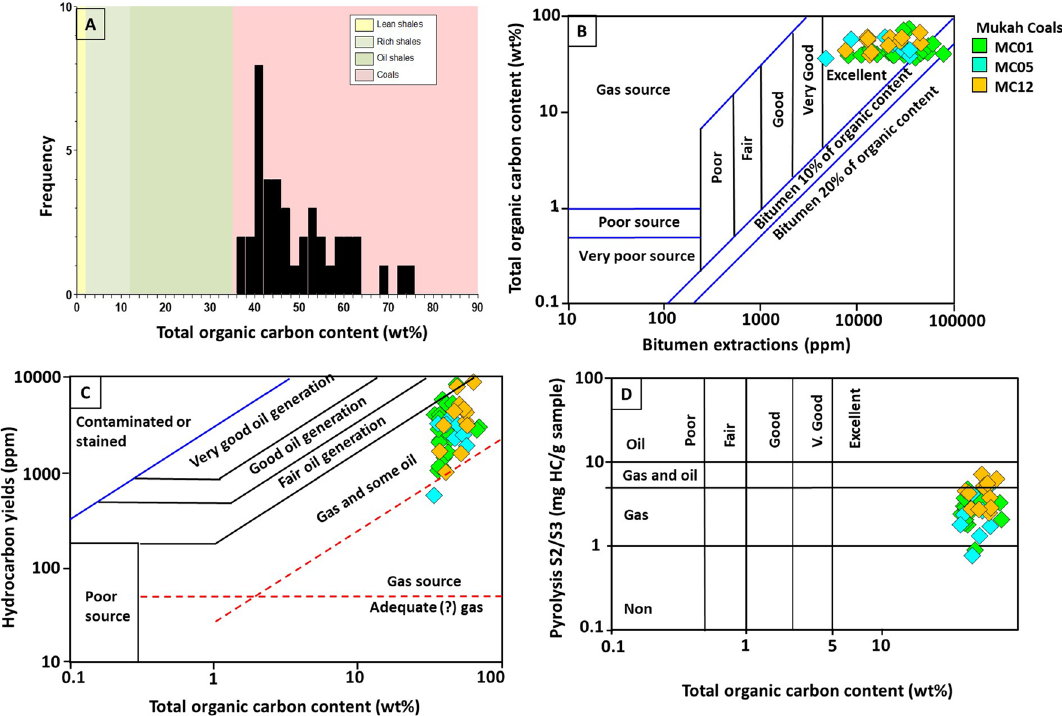
Figure 6. ( A ) Histogram of total organic matter content (TOC), ( B ) pyrolysis S 2 / S 3 , ( C ) distribution of extractable organic matter (EOM) and ( D ) hydrocarbon yield (HC), showing source potential rating and hydrocarbon source rock richness for the selected samples from Mukah coals, Sarawak.